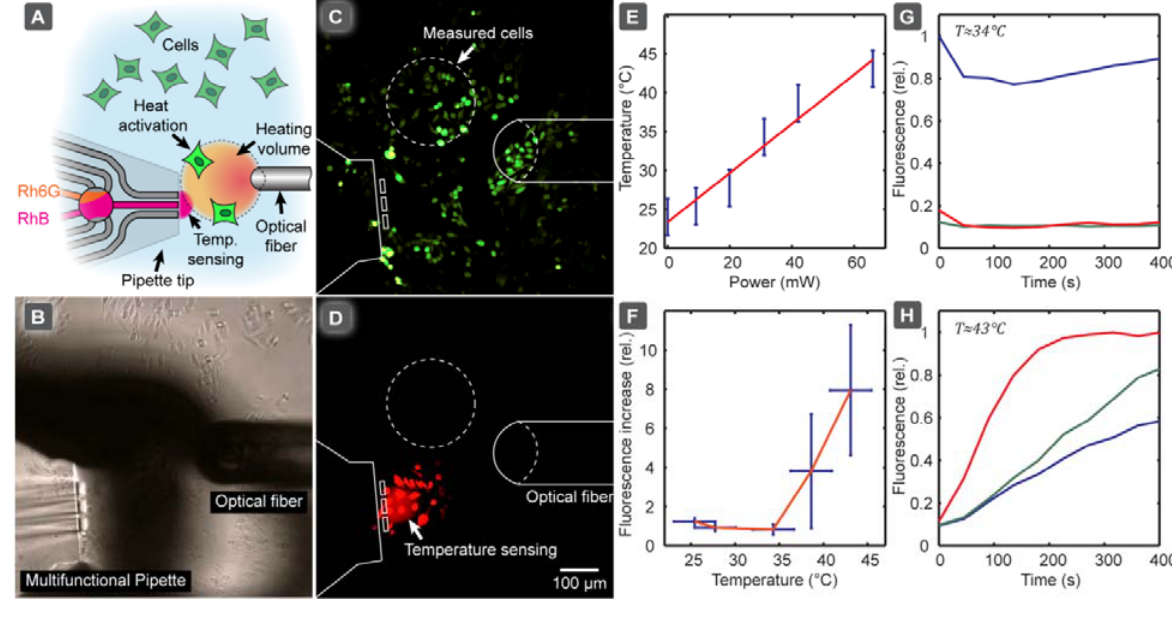
Figure 4. Heat activation of temperature sensitive ion-channels TRPV1, over-expressed in CHO cells, measured as a YO-PRO-1 uptake assay. ( A ) Schematic drawing of the concept of the experiment. Small groups of cells are activated by localized heating with IR-B radiation through the optical fiber (50 µm core). Ion-channel activation is characterized by the passage of the prefluorescent dye YO-PRO-1, while temperature is simultaneously probed using the pipette thermometer. ( B ) Brightfield micrograph of the actual experimental setup, showing the pipette and the optical fiber in close vicinity to the cells. ( C ) Fluorescence images of cells, measuring the intracellular fluorescence ( λ = 488 nm) exc in the region shown in (A). ( D ) Fluorescence image of the same region recorded in the rhodamine channel ( λ = 543 nm). The cells in the vicinity of the HCF zone appear exc brighter due to membrane absorption of rhodamine. ( E ) The equilibrium temperature depending on laser power. ( F ) The cellular fluorescence response depending on the temperature, measured as relative fluorescence increase. ( G – H ) Time course of the cellular fluorescence, after switching on the laser heater (G) below ( ≈ 34 °C) and (H) above ( ≈ 43 °C) the activation temperature. All error bars are given at the 95% confidence